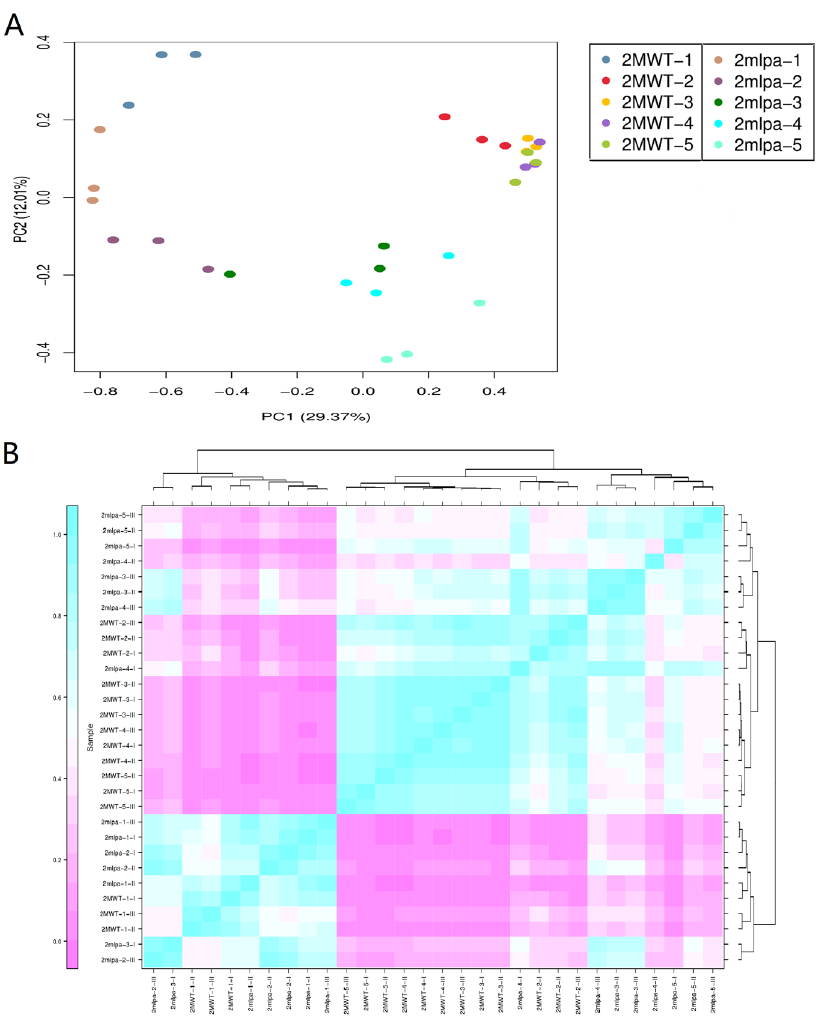
Figure 1. Biological sample variability. ( A ) Principal component analysis plots for 30 2mlpa and 2MWT samples. ( B ) Sample clustering heatmap presenting sample-to-sample